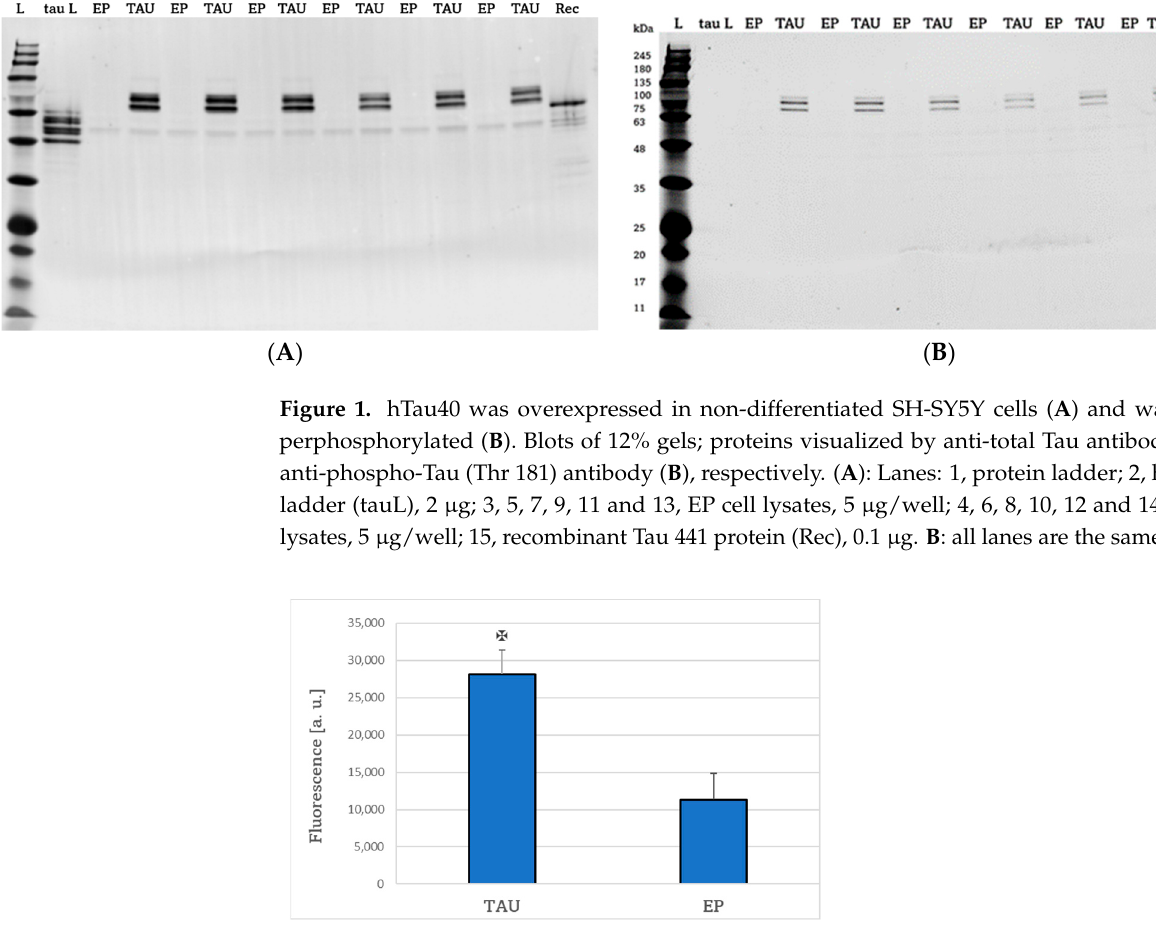
Figure 2. Fluorescence of protein aggregates in TAU-transfected cells was significantly higher compared to empty plasmid- transfected cells (EP), as measured by Aggresome staining; p < 0.05 (TAU vs. EP); n = 3.